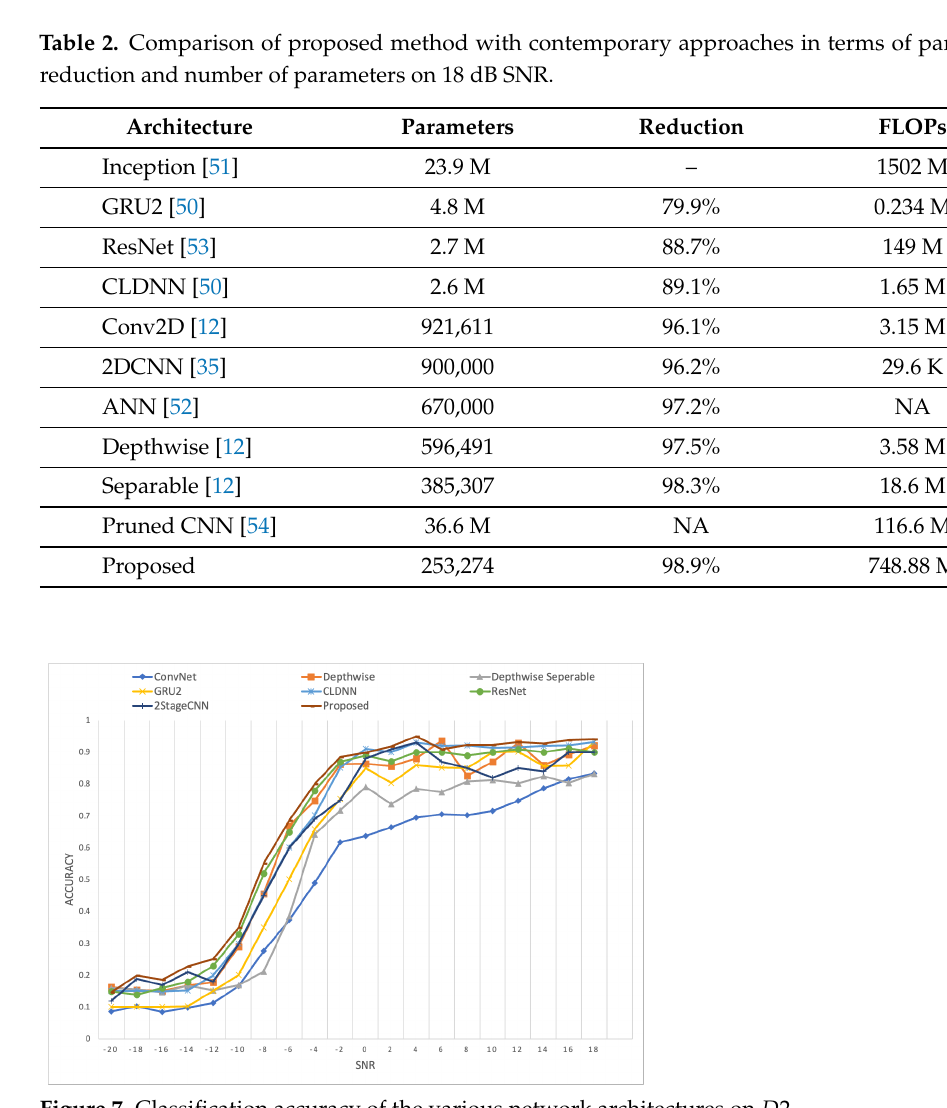
Figure 7. Classification accuracy of the various network architectures on D